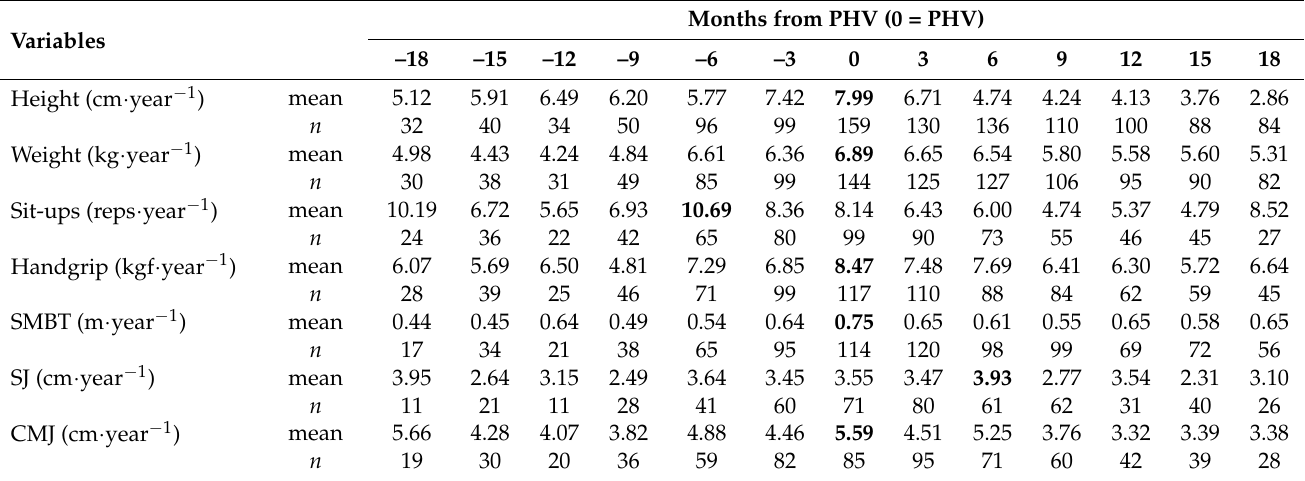
Table 1. Mean constant curves velocities for height, weight and muscular strength components aligned by months from peak height velocity